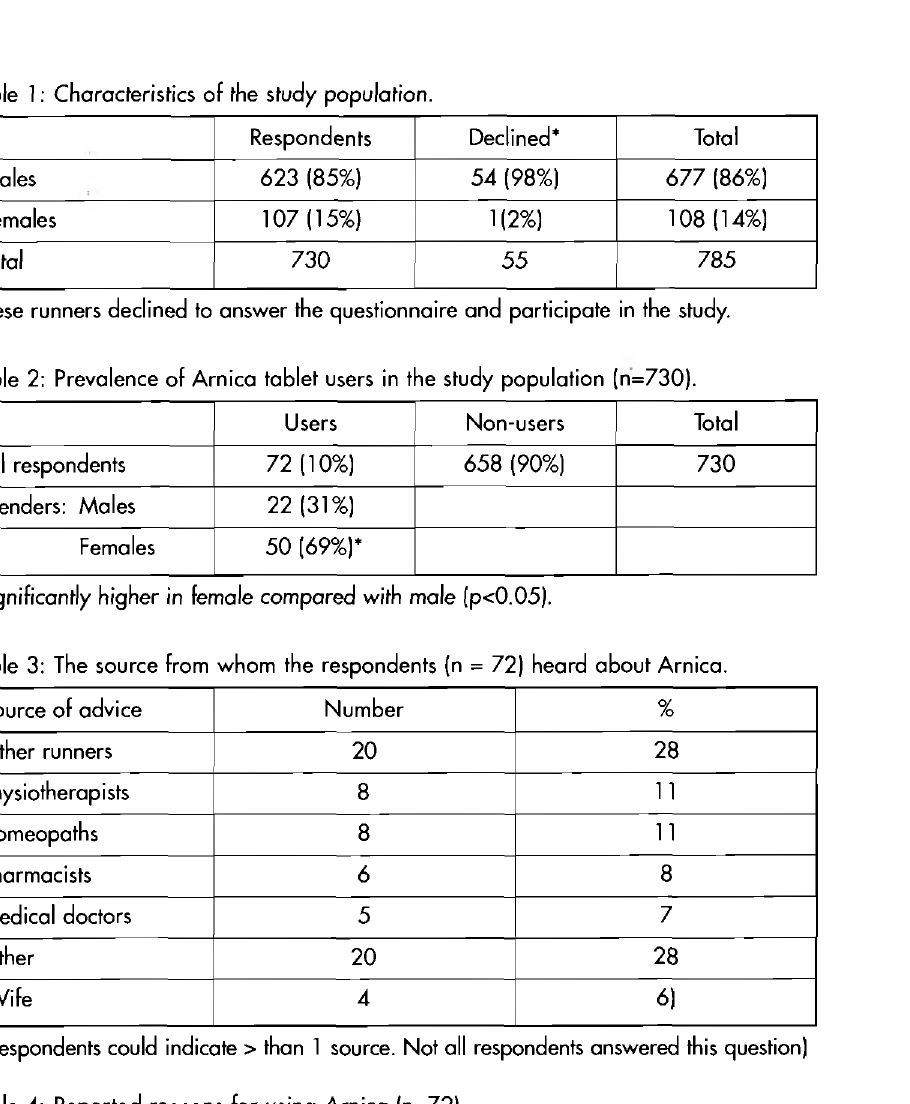
Table 4: Reported reasons for using Arnica